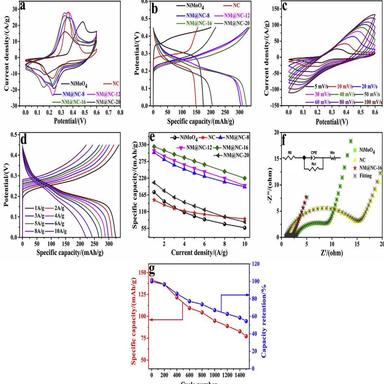
CV curves at 5 mV/s (a); GCD curves at 1 A/g (b); CV curves of NM@NC-16 at different scan rates (c); GCD curves of NM@NC-16 at different current densities (d); Specific capacities at different current densities (e); Electrochemical impedance spectra of the samples (f); Cycling performance of NM@NC-16 at 15 A/g and the corresponding capacity retention (g).